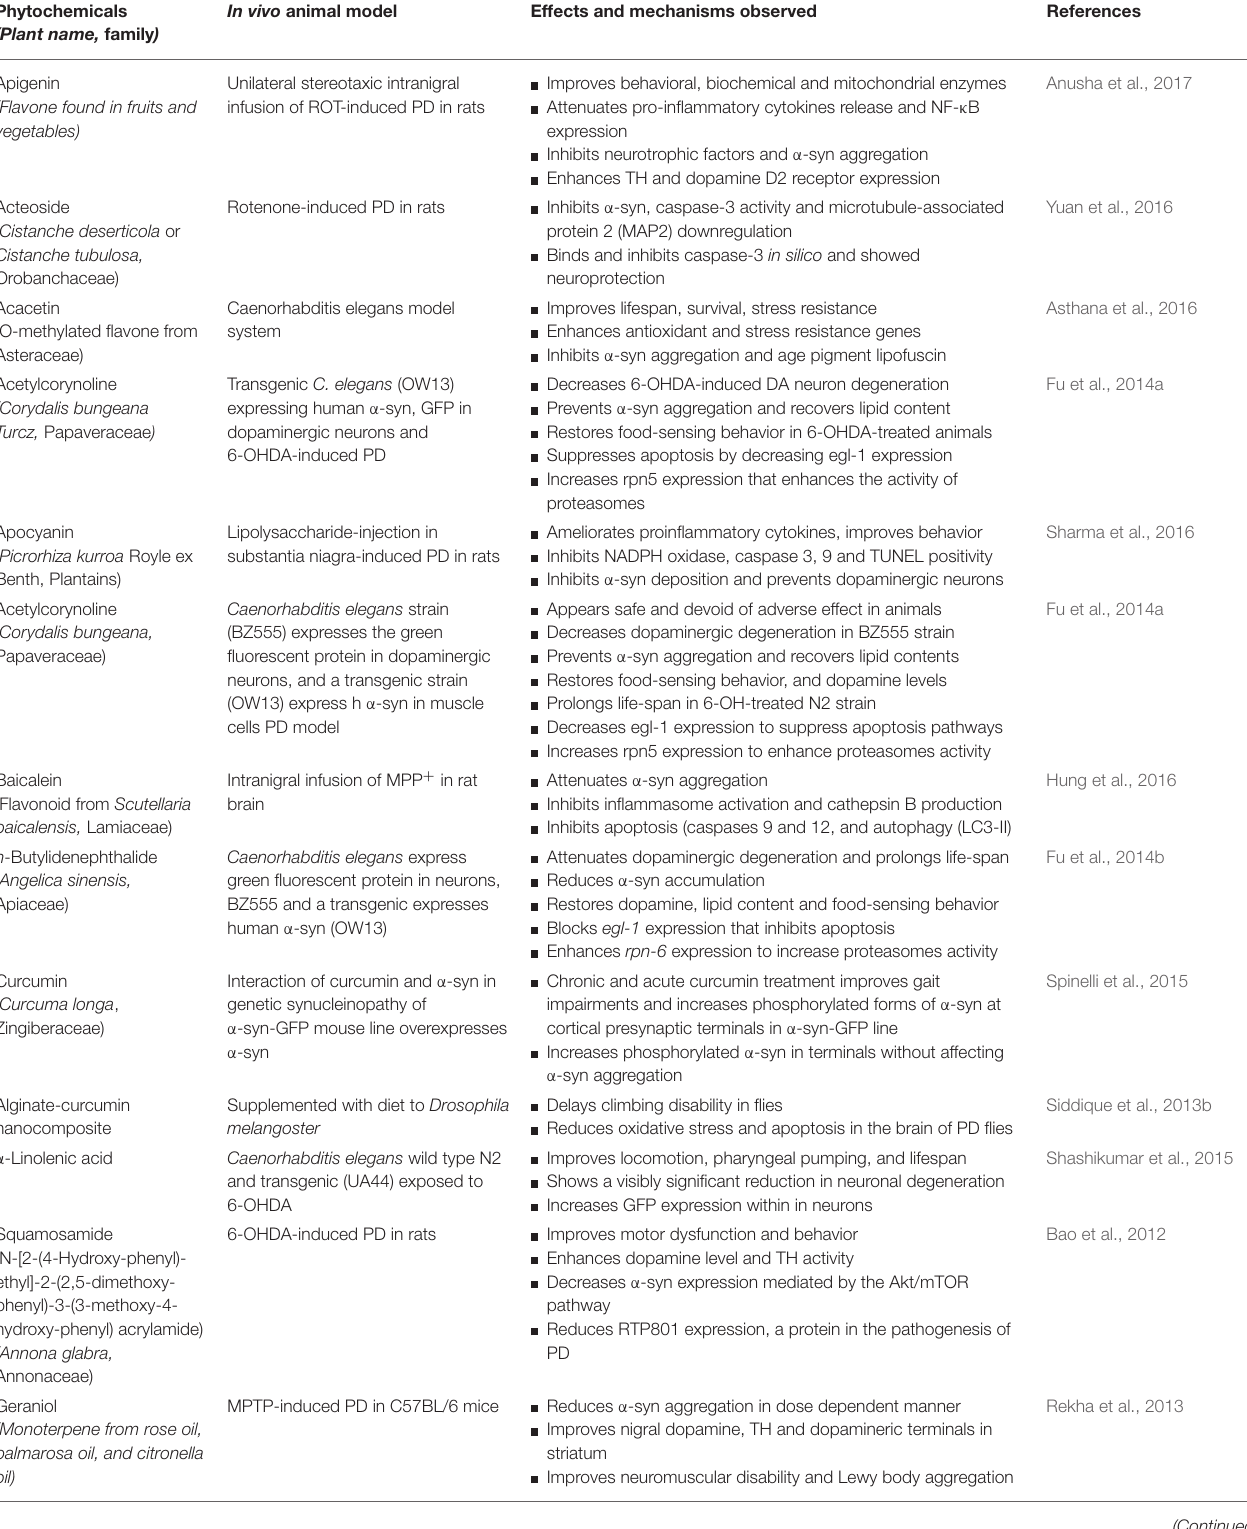
TABLE 3 | The phytochemicals showed neuroprotective effects in the in vivo models of Parkinson’s disease by targeting α